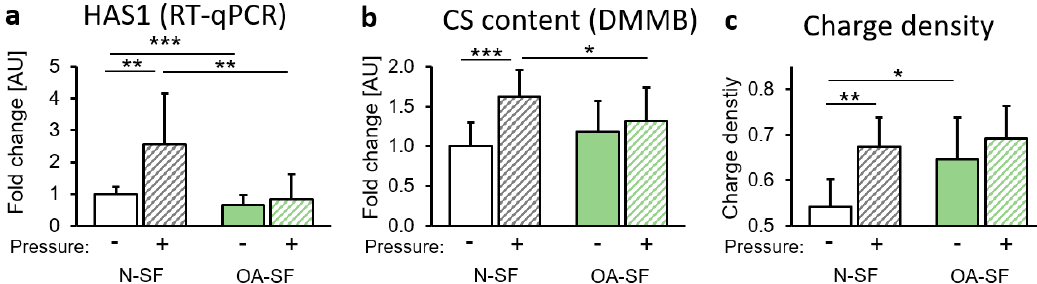
Figure 3. Impact of static compressive force application on glycosaminoglycans (GAG) synthesis. ( a ) Gene expression of hyaluronan synthase 1 (HAS1) by N-SF and OA-SF after 48 h with or without static compressive force application. ( b ) Chondroitin sulphate (CS)-content (DMMB assay) and ( c ) charge density (HPLC) of GAGs of N-SF and OA-SF after 48 h with or without static compressive force application. AU: arbitrary units; RT-qPCR: n = 9; DMMB: n = 9. * p ≤ 0.05, ** p ≤ 0.01, *** p ≤ 0.001. Statistics: Welch-corrected ANOVA with Games-Howell post ‐ hoc ‐ tests.